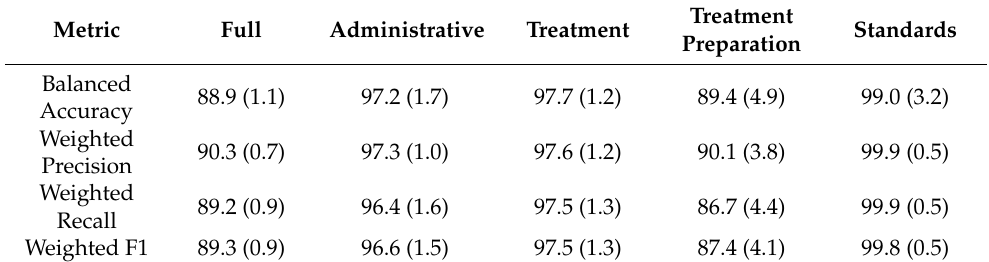
Table 3. Model performance on test data with tf-idf + LSA + MLP.